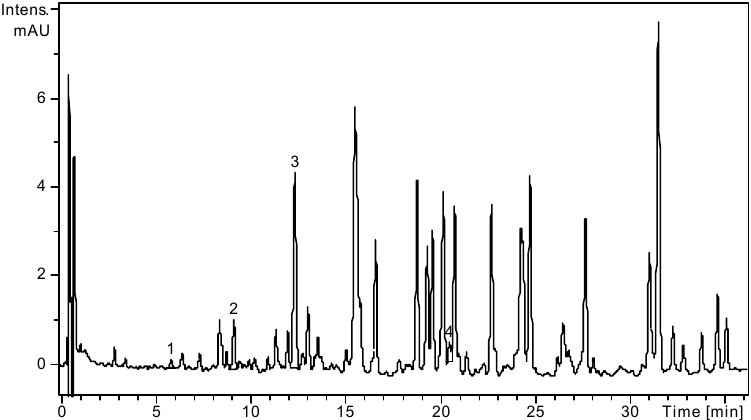
Figure 1. HPLC chromatogram of a non-hydrolysed sample of A. senescens subsp. montanum (A2 N).